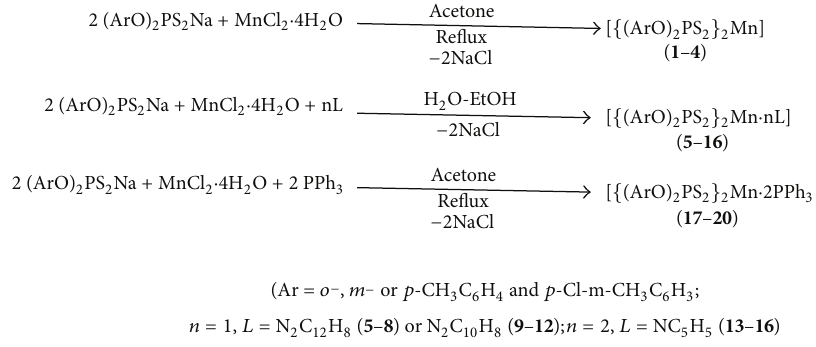
Scheme 1: Reactions showing synthesis of O,O 󸀠 -( o -, m -, p - and p -Cl- m -ditolyl) dithiophosphato complexes of Mn(II) and their adducts with nitrogen and phosphorus donor ligands. Table 2: IR spectral data for Mn(II) ditolyldithiophosphates (cm − 1 ). S.